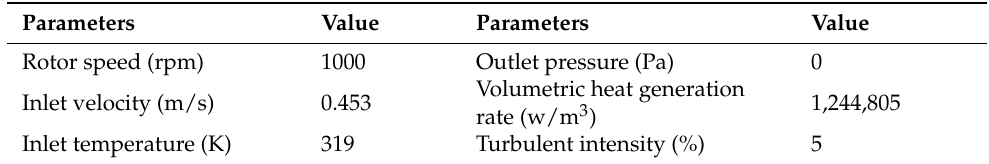
Table 2. Parameters of the thermal model.